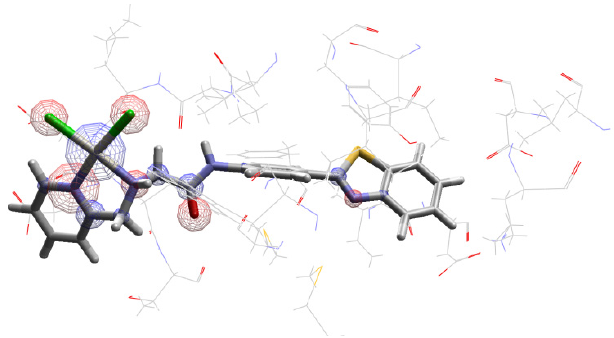
Figure 5. Electrostatic interactions for complex inside active site of Figure 5 . Electrostatic interactions for complex inside active site of PI3K.